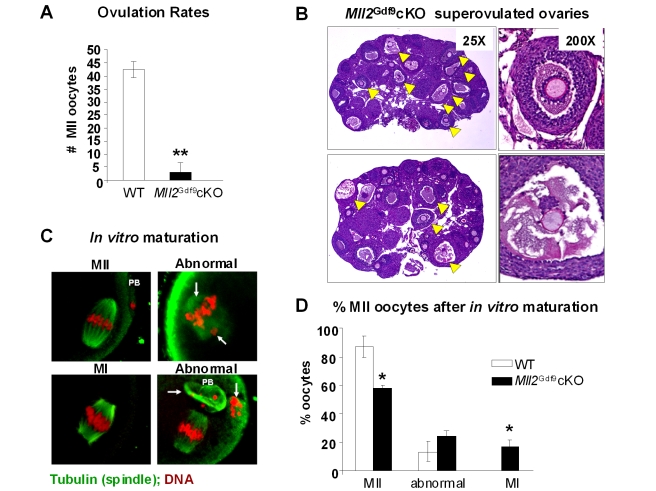

Mll2Gdf9 cKO females show impaired ovulation.(A) Ovulation rates were significantly reduced in 3-wk-old superovulated Mll2Gdf9 cKO females (Student's t test, ** p<0.01). Means ± S.E. are shown (five individual females were used; n = 5). (B) PAS-stained ovaries from superovulated 3-wk-old Mll2Gdf9 cKO mice showed trapped oocytes (yellow arrowheads), which correlated with decreased ovulation rates in this mouse line. (C) In vitro oocyte maturation studies; representative single plane confocal laser microscopy micrographs of peri-ovulatory oocytes cultured for 16 h to allow resumption of meiosis; arrows show lagging chromosomes. Magnification: 800×. Abbreviations: MI, meiosis I; MII, meiosis II; PB, polar body. (D) Percentages of meiosis I (MI), meiosis II (MII), or abnormal oocytes after 16 h in culture (ANOVA test, * p<0.05). Means ± S.E. of four independent experiments are shown; a total of 120 oocytes per genotype were analyzed.